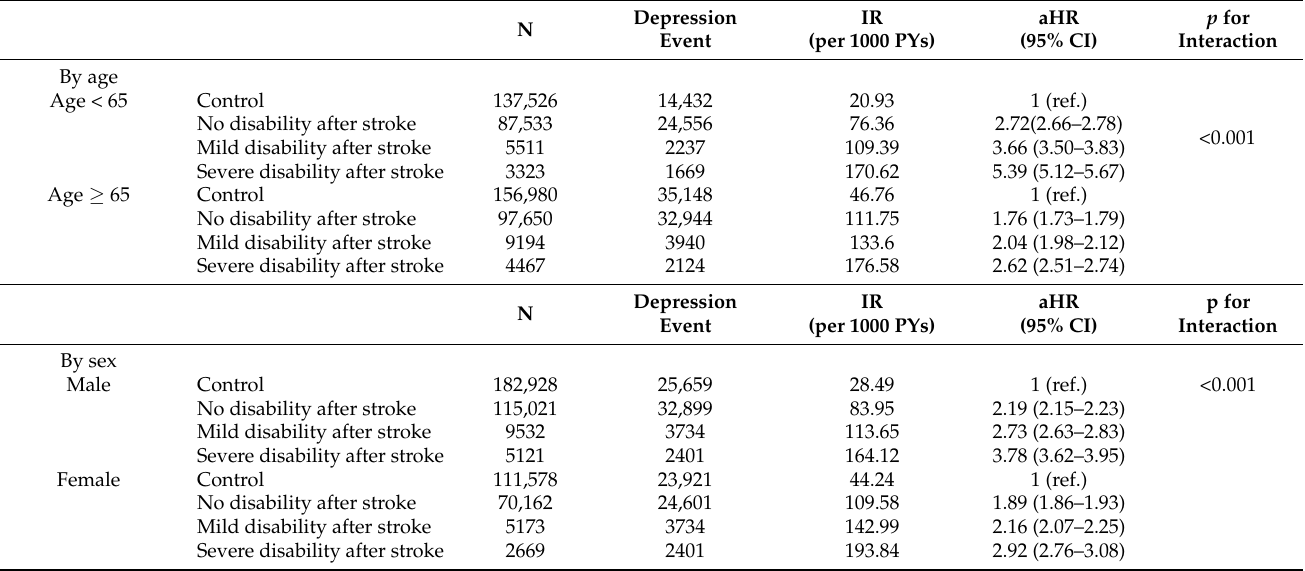
Table 4. Risk of depression in stroke survivors and control group according to age and sex.